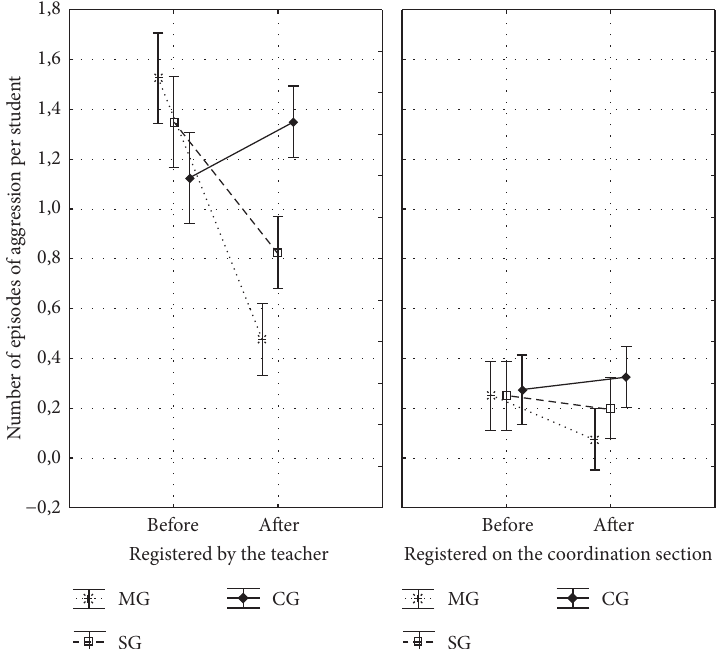
Figure 2: Records of teachers and coordination register books, in which aggression episodes involving students and students and parents complaints are registered. Before the intervention: observations from April/May were analyzed. After the intervention: observations from September/October were analyzed.